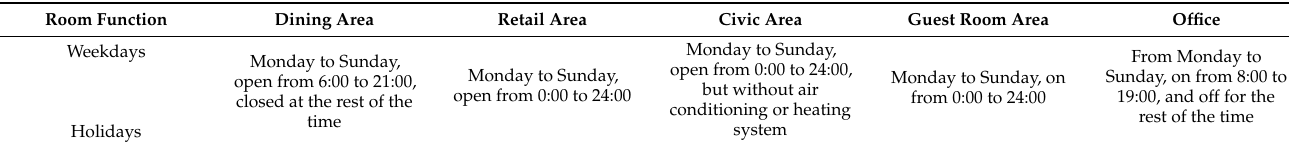
Table 4. Operating hours of air-conditioning and heating systems.